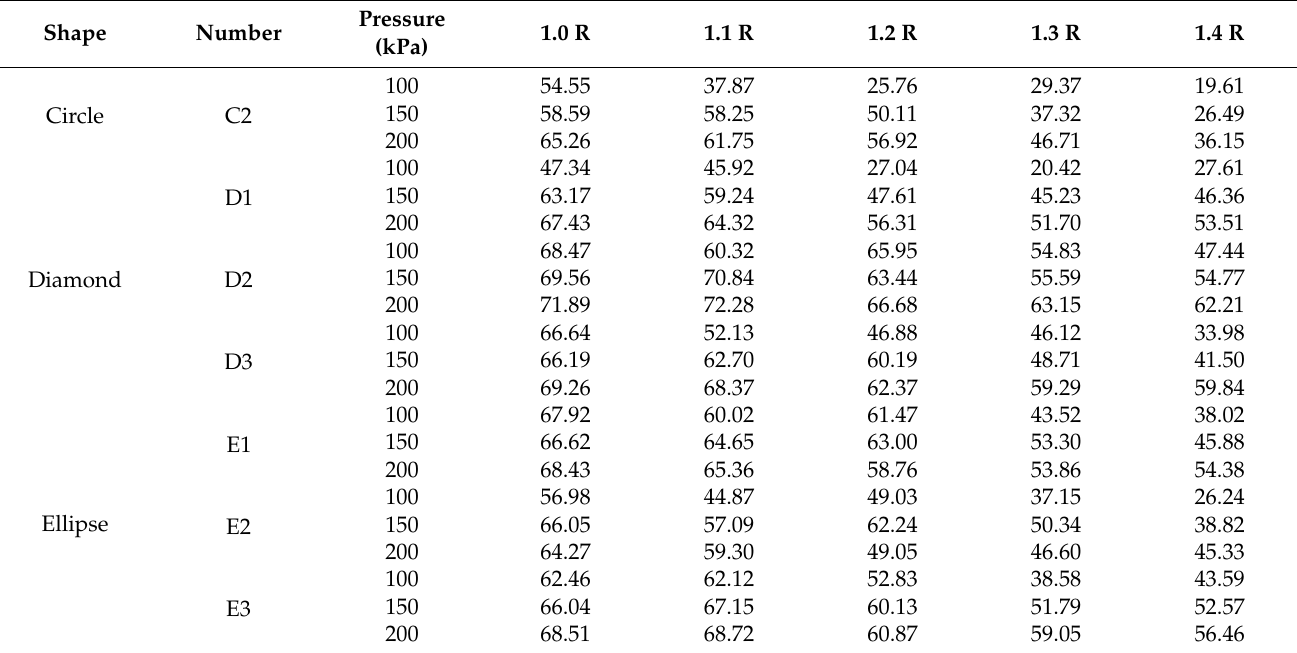
Table 6. Combination uniformity coefficients of each nozzle under different pressures and combina- tion